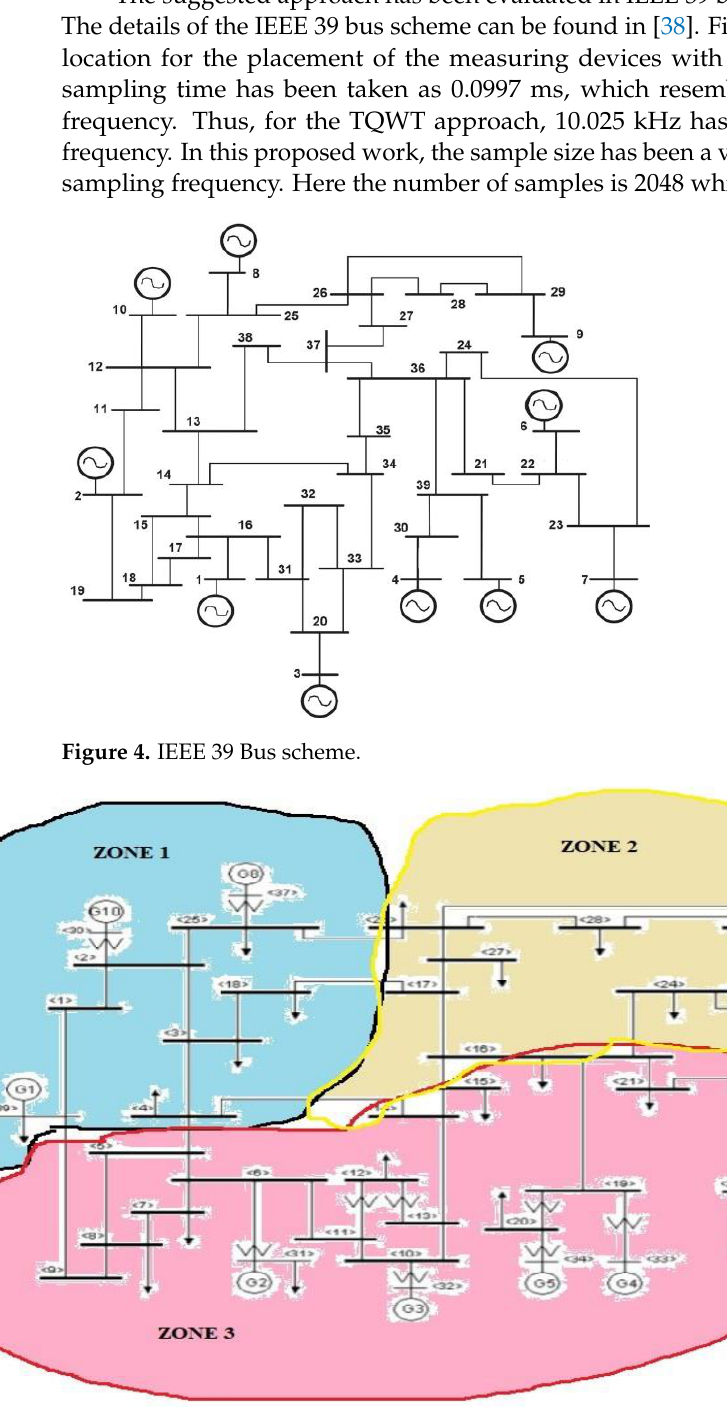
Figure 5. Graph Theory-based Zone Selection.